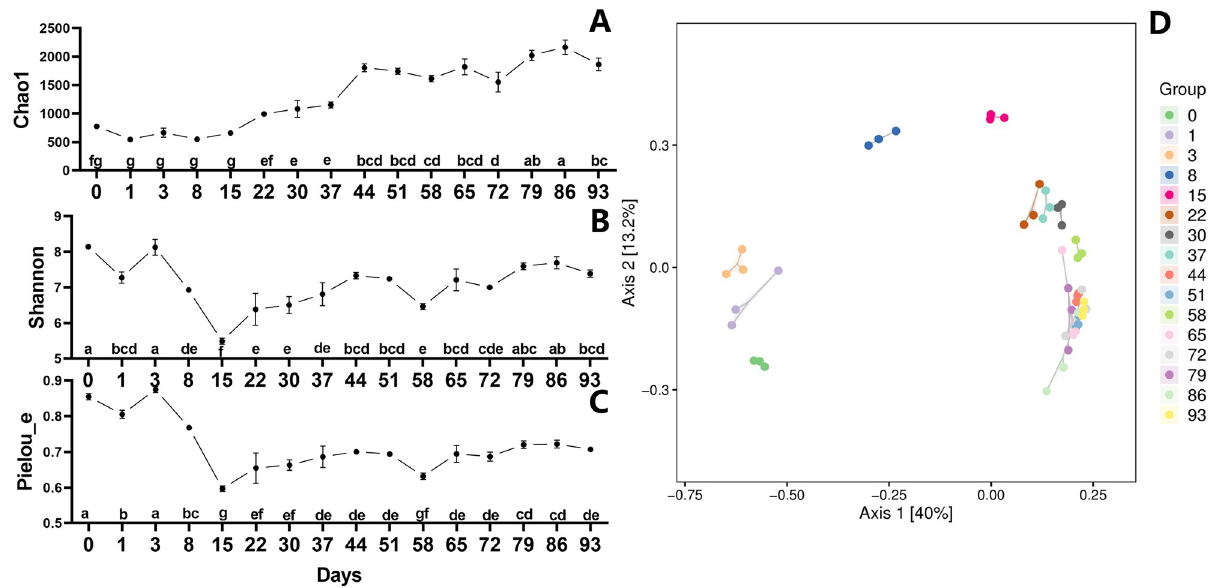
Fig 4. Changes in bacterial alpha and beta diversity during fermentation. Chao1 (A), Shannon (B), Pielou_e (C), and Principal coordinate analysis (PCoA) (D) were assessed during the EFS process. Statistical assessment was carried out with one-way ANOVA followed by post hoc test using Dunn’s multiple comparison test. Values with different letters are significantly different at P <